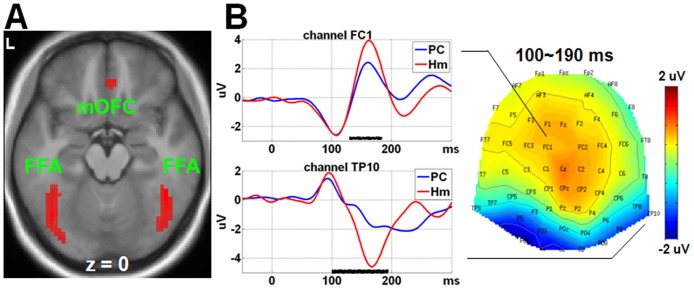
fMRI and ERP findings for the main effect of Investor.Human (Hm) versus computer (PC) investor elicited (A) stronger activations in bilateral fusiform face areas (FFA) and right medial orbitofrontal cortex (mOFC) (p < 0.05 FWE correction, cluster ≥ 20 voxels), and (B) more positive-going amplitudes in the frontal-central sites (close to FC1) and more negative-going amplitudes in the right occipito-temporal sites (close to TP10) within 100~190 ms time-locked to stimulus. The SPM T map (for fMRI data) and the scalp topography (for ERP data) represented the contrast of (Hm-PC). The waveforms in the representative channel are shown for the ERP findings. The horizontal black bars represent the time windows detecting statistical significance. Here, 0 ms indicates the time point of stimulus onset. L = left.